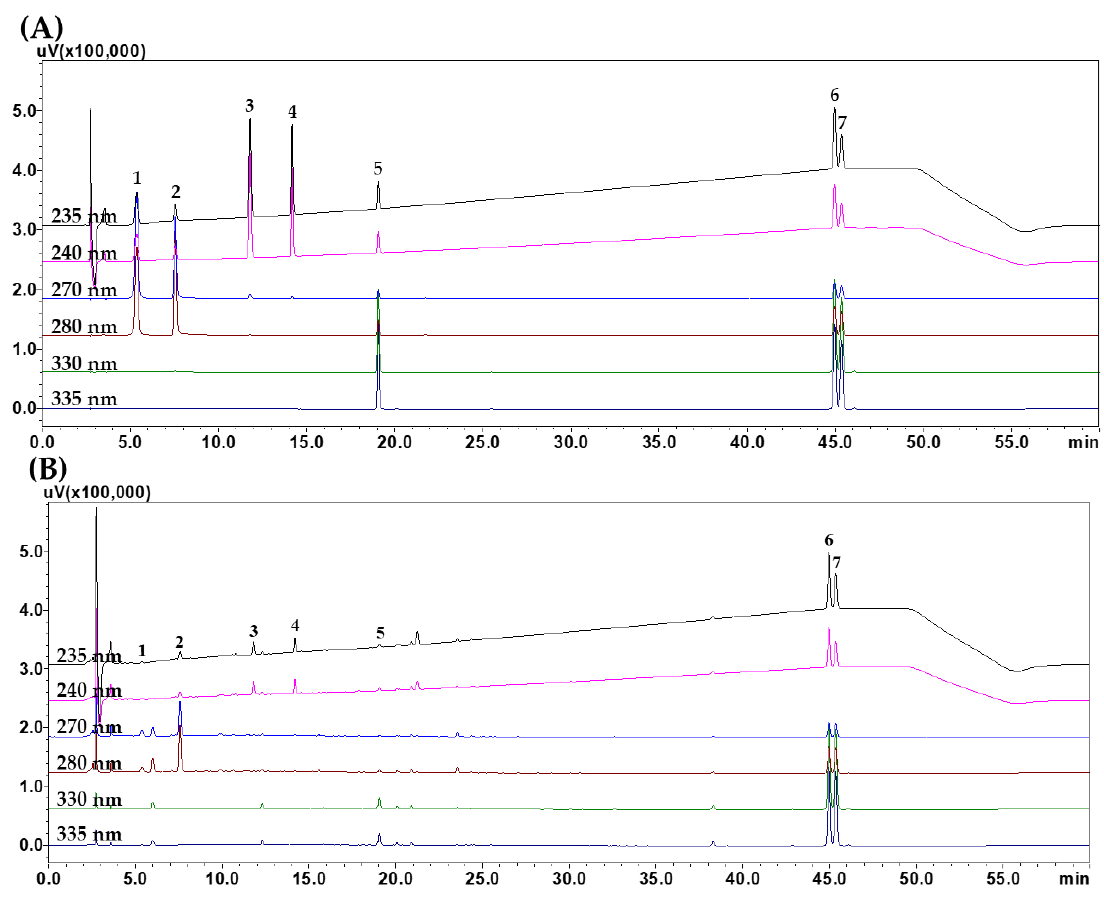
Figure 1. Representative HPLC chromatograms of the standard solution ( A ) and GJD–1 sample ( B ). Gallic acid (1), 5-(hydroxymethyl)furfural (5-HMF, 2), morroniside (3), loganin (4), nodakenin (5), decursin (6), and decursinol angelate (7). The concentrations of the compounds in the mixed standard solution were 20.00 µg/mL (compounds 2 and 5 ), 30.00 µg/mL (compounds 1 , 3 , and 6 ), and 40.00 µg/mL (compounds 4 and 7 ). Table 2. Method validation with respect to measured wavelength, linear range, regression equation, coefficient of determination ( r 2 ), limit of detection (LOD), and limit of quantitation (LOQ) values for simultaneous determination of seven target components using